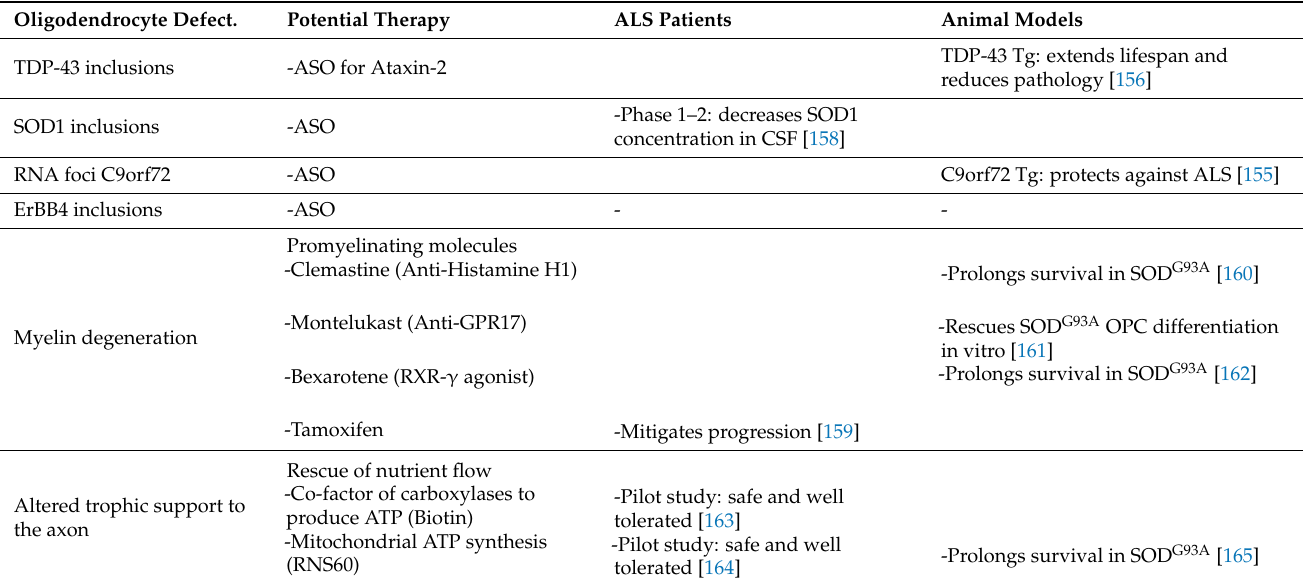
Table 1. Potential therapies targeting oligodendrocyte defects in ALS. Abbreviation: ASO, antisense oligonucleotide; CSF, cerebro-spinal fluid; OL, oligodendrocyte; OPC, oligodendrocyte progenitor cell; Tg, transgenic. Oligodendrocyte